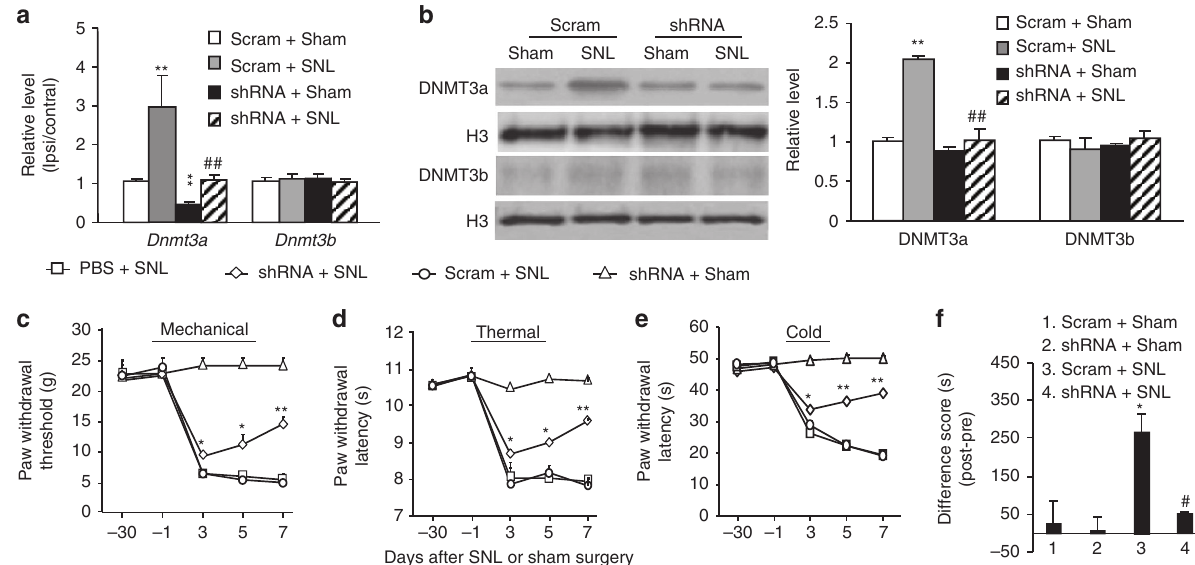
Figure 4 | Blocking DRG DNMT3a increase attenuates neuropathic pain development in rats. Scram: AAV5-scrambled Dnmt3a shRNA. shRNA: AAV5- Dnmt3a shRNA. ( a ) Levels of Dnmt3a and Dnmt3b mRNAs in the ipsilateral and contralateral L5 DRG on day 7 post-SNL or sham surgery from the treated groups as shown. n ¼ 6 rats per group. One-way ANOVA followed by post hoc Tukey test, F group (3, 15) ¼ 7.25 for Dnmt3a mRNA and F group (3, 15) ¼ 0.29 for Dnmt3b mRNA. ** P o 0.01 versus the corresponding scram plus sham group. ( b ) Levels of DNMT3a and DNMT3b proteins in the ipsilateral L5 DRG on day 7 post-SNL or sham surgery from the treated groups as shown. n ¼ 6 rats per group. One-way ANOVA followed by post hoc Tukey test, F group (3, 11) ¼ 46.6 for DNMT3a protein and F group (3, 11) ¼ 0.54 for DNMT3b protein. ** P o 0.01 versus the corresponding scram plus sham group.